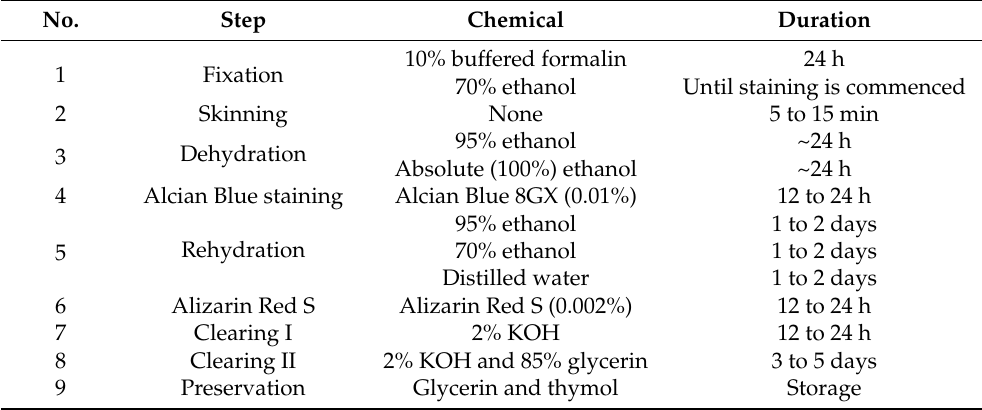
Table 1. Summary of the procedures of the modified double-staining technique for the skeletal system.